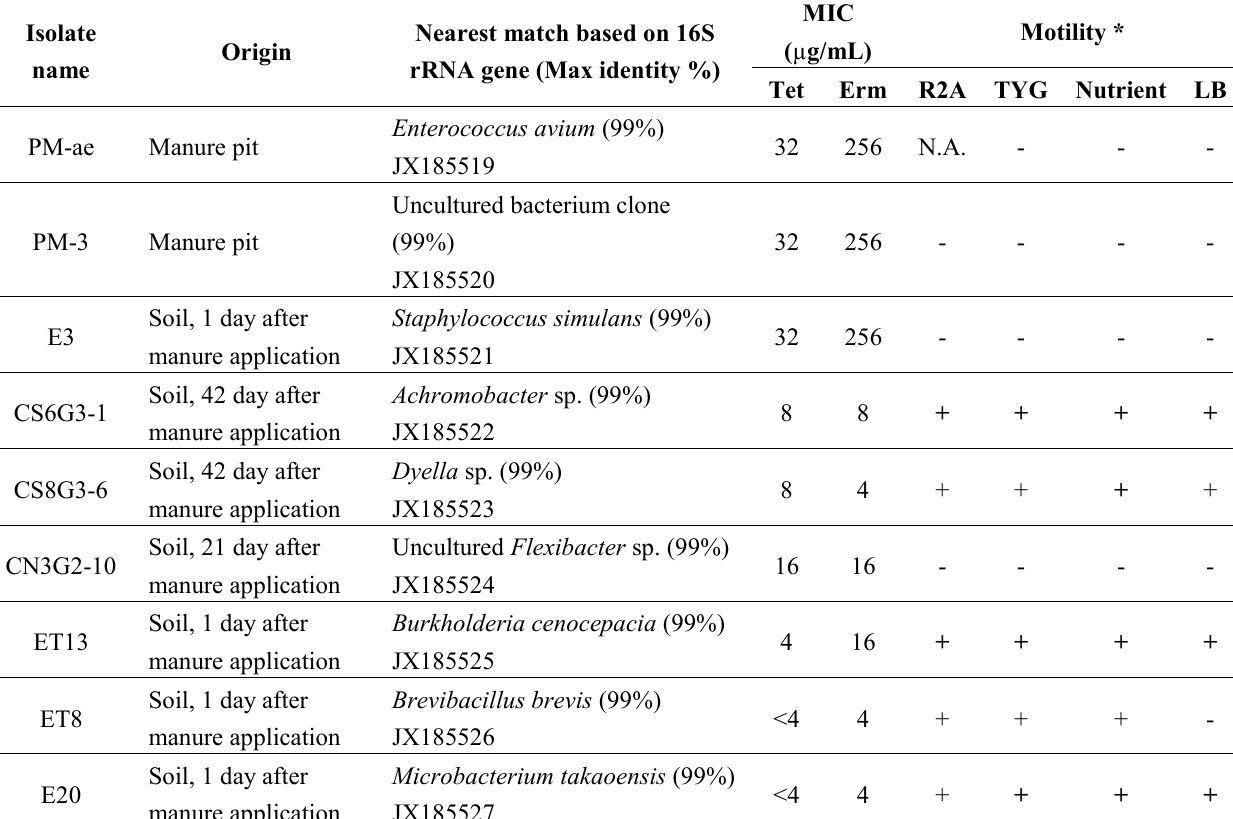
Table 2. Bacterial species isolated from soil samples. The minimum inhibitory concentrations (MIC) in tetracycline and erythromycin are listed. * denotes that the bacterial isolate exhibits either one or more of the examined motility traits ( i.e. , swimming, swarming, and twitching). N.A. denotes no growth in that particular